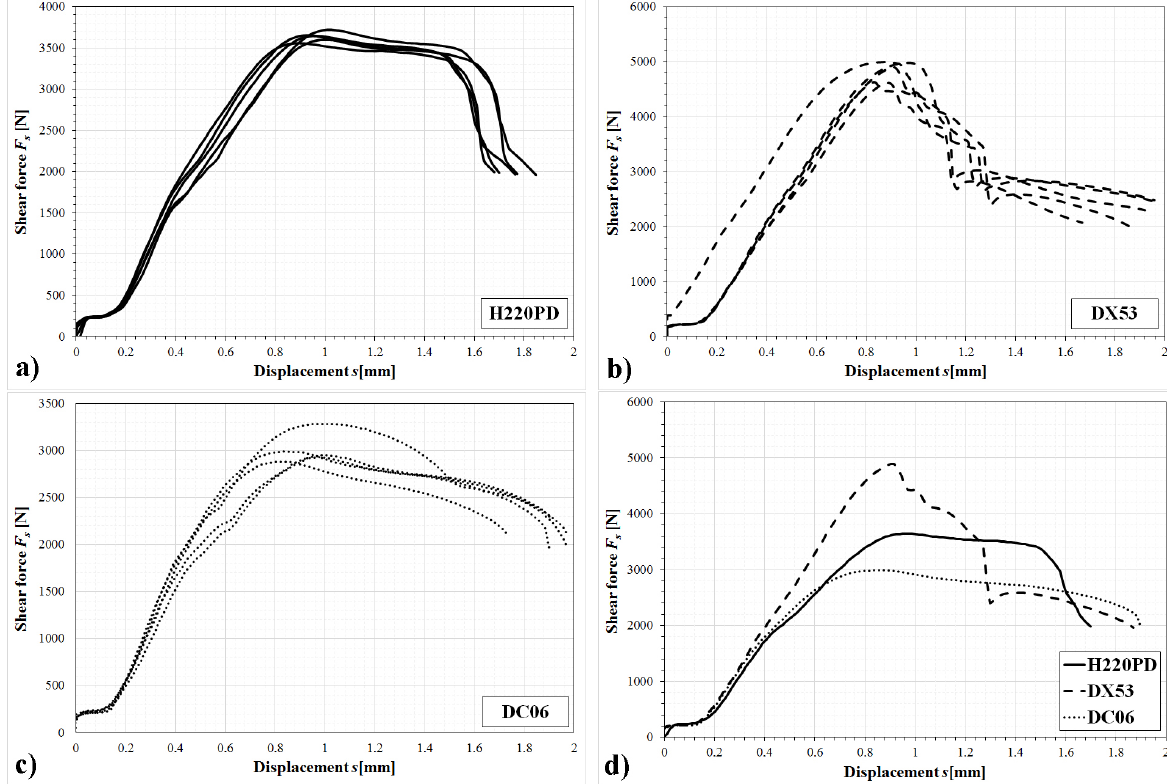
Figure 5: Shearing curves of (a) H220PD steel, (b) DX53 steel, (c) DC06 steel and (d) comparison of shearing curves of H220PD, DX53 and DC06